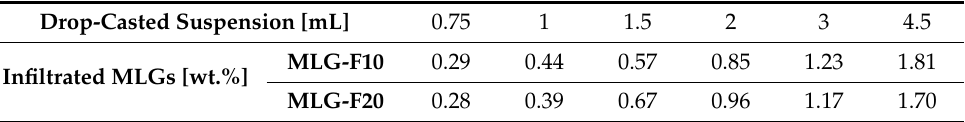
Table 2. Amount of suspension used for PDMS foam infiltration and weight percentage of MLGs with respect to the PDMS weight for F10 and F20 foam